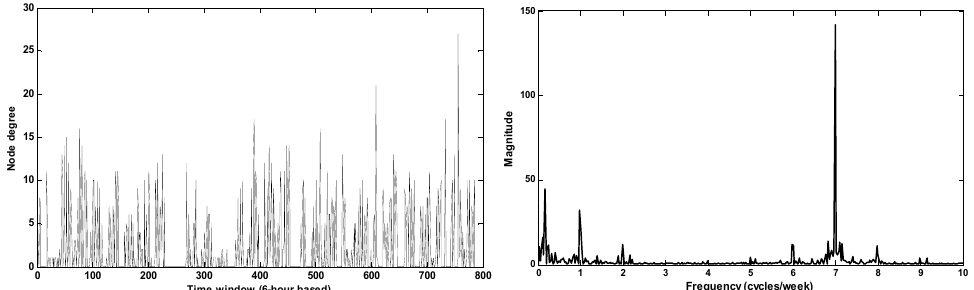
Figure 4. ( left ) The changes of degree of an illustrative hub node in Reality (measured by node degree in a 6-h time window), and ( right ) the detected periodicities of the node’s degree. This describes that the node popularity in the mobile social network fluctuates over time and has a weekly period.